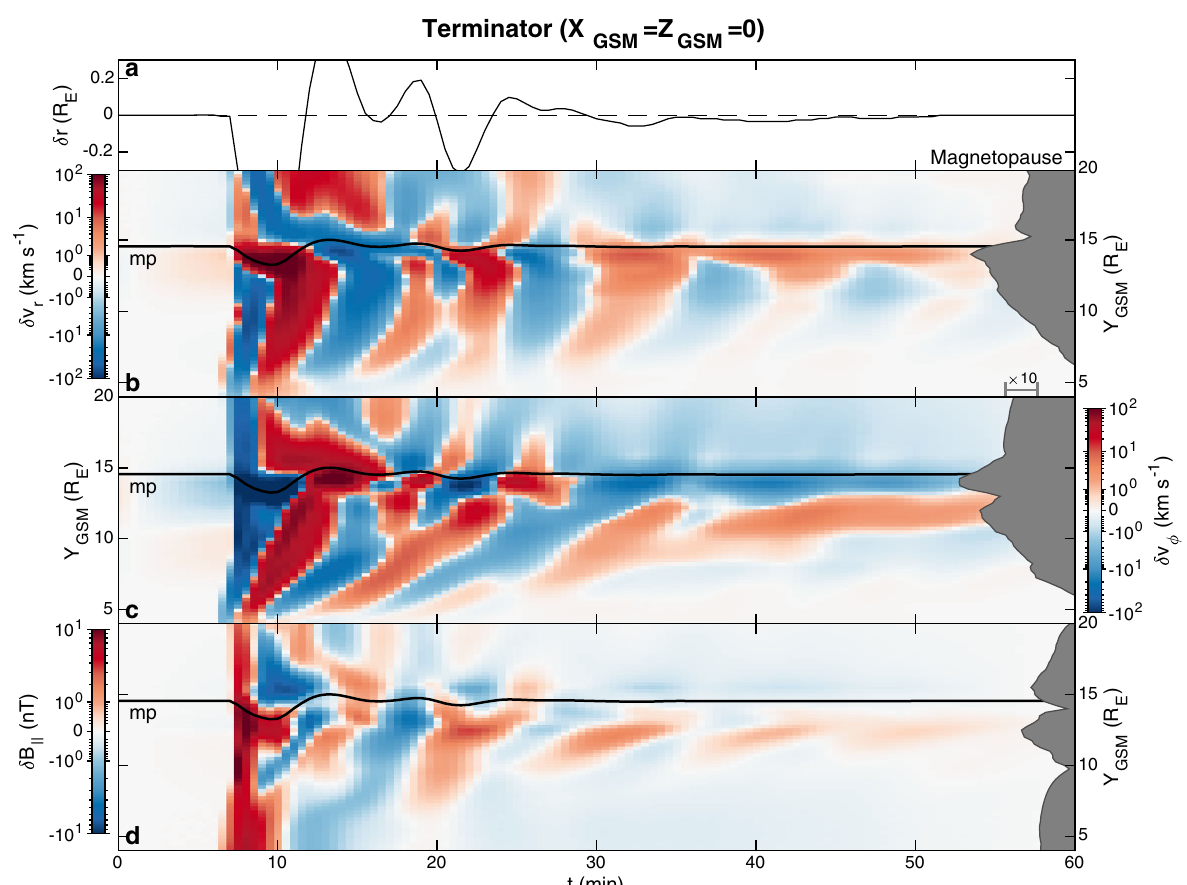
Fig. 5 Un fi ltered perturbations in MHD simulation along the equatorial terminator. Formatting is the same as Fig. 4. a shows the motion of the magnetopause (black) about equilibrium. Subsequent panels show perturbations in the b radial velocity, c azimuthal velocity and d compressional magnetic fi eld components (note the bi-symmetric log scale). Median absolute perturbations by distance are displayed to the right as the dark grey areas on a logarithmic scale. The magnetopause (black) location is also